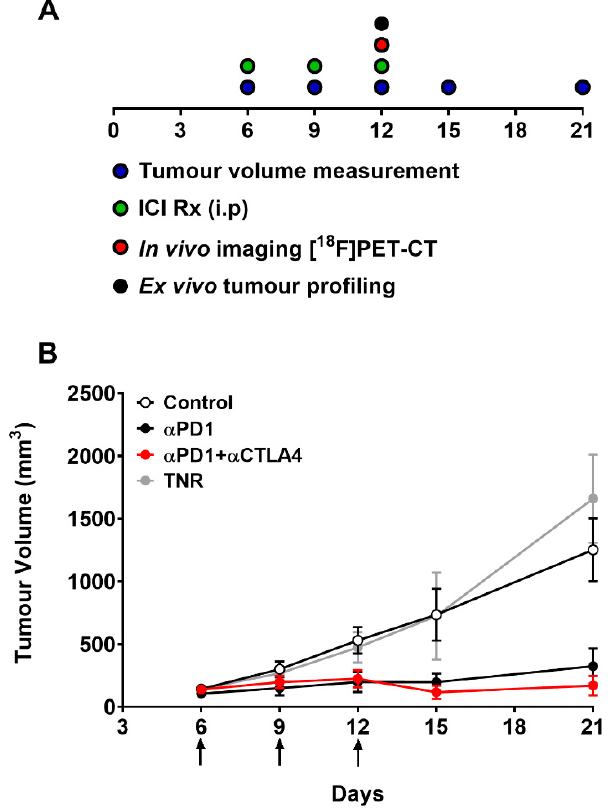
Figure 2. ( A ) Schematic representation of timeline showing dosing, measurement and imaging regimen. Mice ( n = 10–15) were i.p. treated with control IgG, α PD1 monotherapy or combined α PD1 + α CTLA4 on days 6, 9, and 12 post tumour implantation. ( B ) Average tumour volume of CT26 tumour-bearing mice on days 6, 9, 12, 15, 19 and 21 post tumour implantation. Data are represented as the mean ± S.D. Data are shown post therapy response separation and represented as the mean ± S.D. (TNR, treated non ‐ responder).